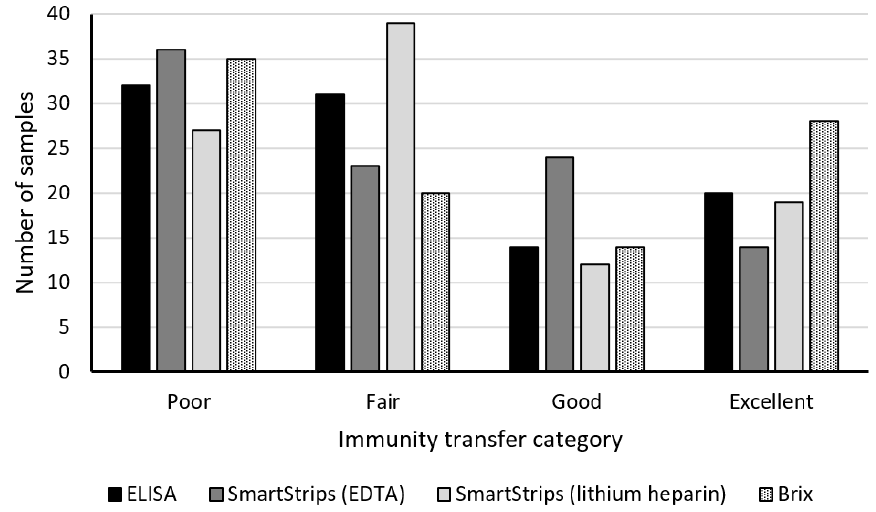
Figure 4. Sample size for each category of TPI status for ELISA, the quick test (SmartStrips TM ) with EDTA anticoagulant, SmartStrips TM with lithium heparin anticoagulant, and Brix refractometer (total n = 97 for each method). See Table 1 for the definition of the categories.